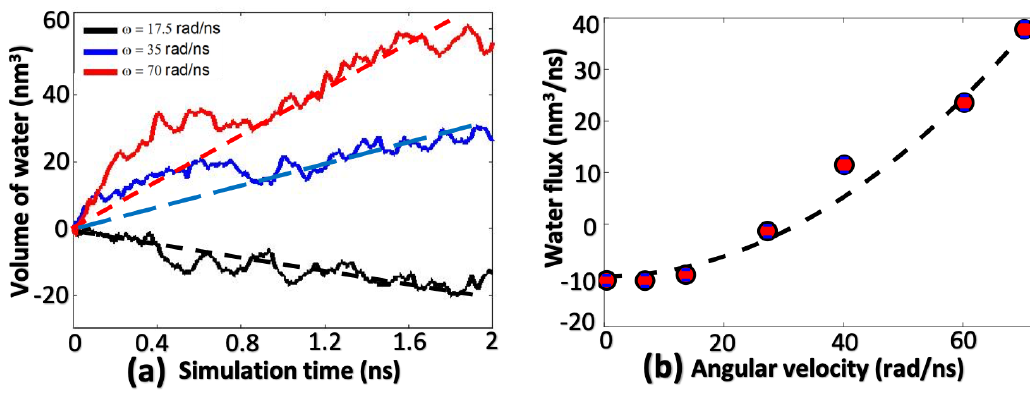
Figure 8. ( a ) Volume of filtrated water as a function of simulation time. ( b ) Water flux as a function of angular velocity.